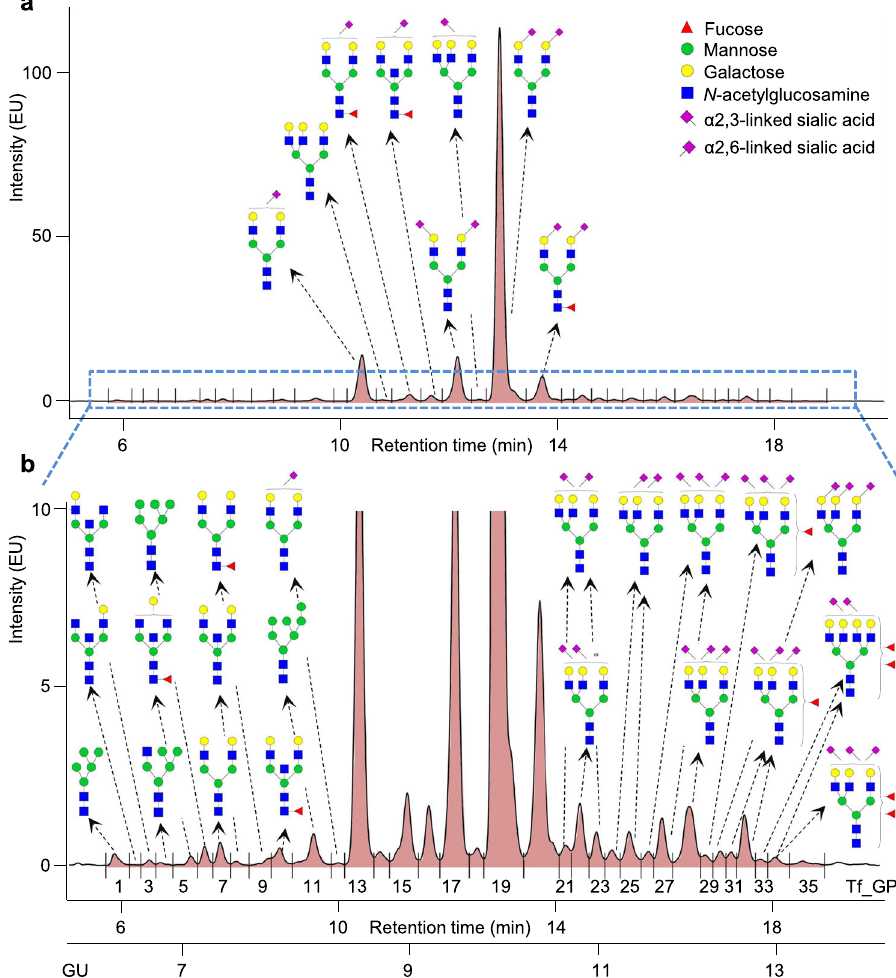
Fig. 2 N-glycosylation pro fi le of human plasma transferrin (Tf) obtained by ultra-high-performance liquid chromatography based on hydrophilic interactions with fl uorescent detection (HILIC-UHPLC-FLD). The most abundant glycan structure in each Tf glycan peak (Tf_GP) is shown. For full characterization see Supplementary Table 2. Sialic acid linkages are assigned based on matrix-assisted laser desorption/ionization time-of- fl ight mass spectrometry (MALDI-TOF-MS) analysis of fractionated 2-aminobenzamide (2-AB) labeled and ethyl-esteri fi ed N-glycans eluting in individual Tf_GPs. Structural schemes are given according to Consortium for Functional Glycomics (CFG) guidelines. EU emission unit, GU glucose unit. a The eight most abundant Tf N-glycan structures are shown. b Zoomed-in view showing less abundant